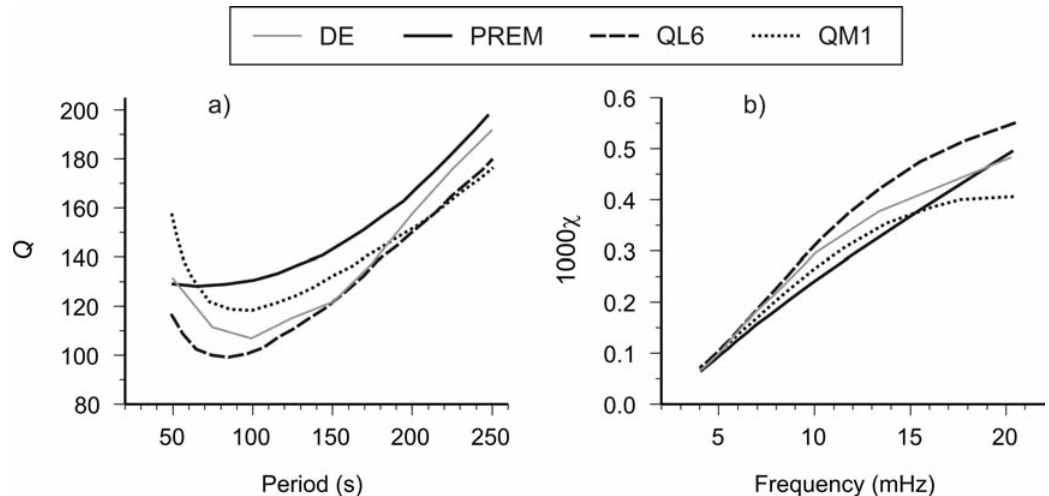
Figure A1. Apparent attenuation for four spherically symmetric global Rayleigh-wave models. a) In Q ( f ) form. b) In | ( f ) form. DE, [Dalton and Ekström 2006]; PREM, [Dziewonski and Anderson 1981]; QL6, [Durek and Ekström 1996]; and QM1, [Widmer et al. 1991]. Note that (cid:0)( f ) for PREM is near linear across the entire 50-250-s period